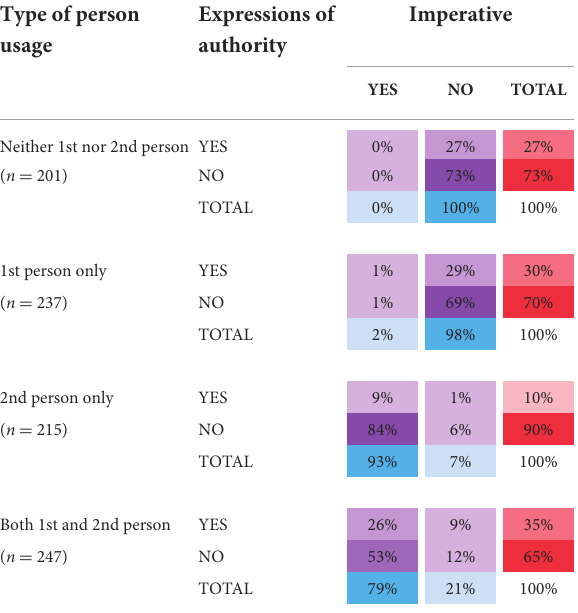
TABLE 3 The distribution of the presence (YES) and absence (NO) of the imperative mood and expressions of authority within each type of person